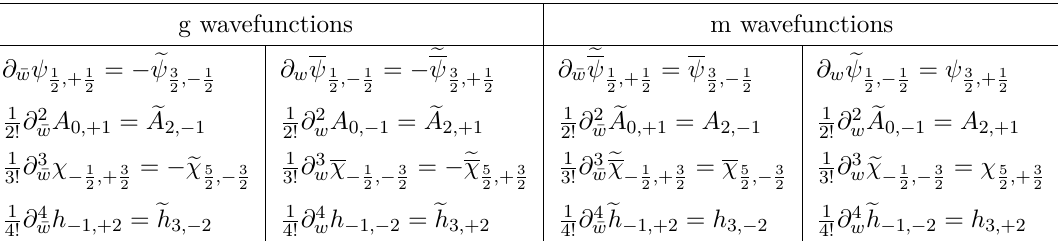
Table 20. Type III primary descendant